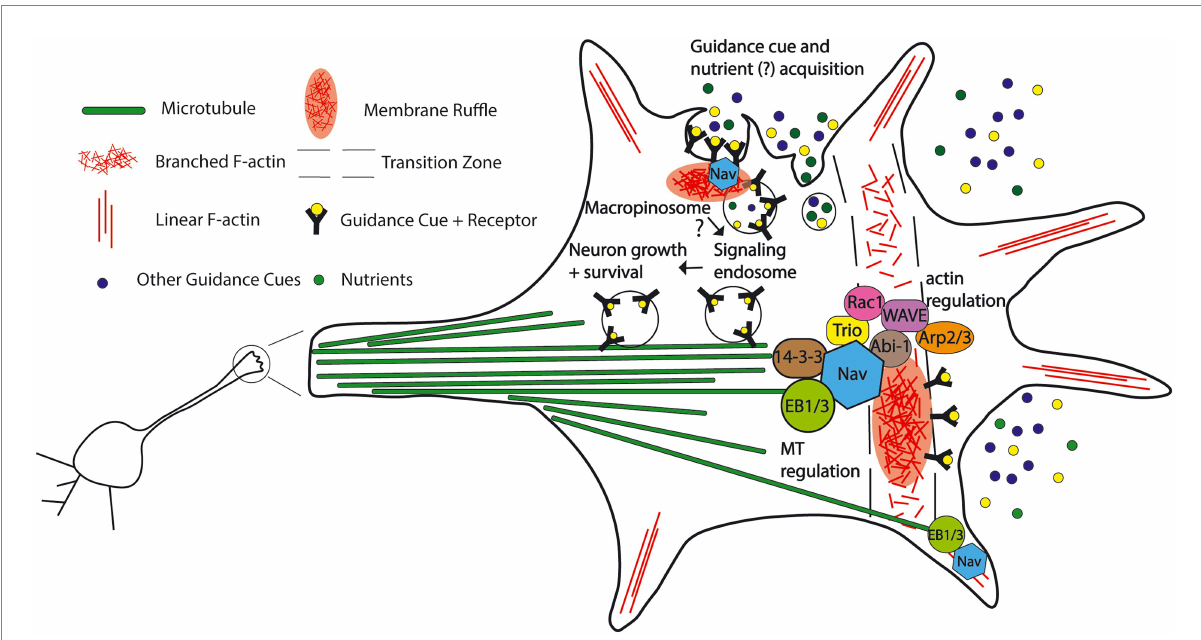
FIGURE 7 Proposed model for the functions and protein interactions of the Neuron Navigators in the neuronal growth cone. A subset of the Navigator population localizes to the plus-tip of microtubules via binding to end binding protein, cross-links microtubules and actin, and influences cytoskeleton dynamics in the growth cone. Nav1 promotes actin-rich membrane ruffles in the transition zone of the growth cone. This may be via binding to other cytoskeleton-associated molecules such as Trio, 14–3-3 family proteins, and members of the WAVE complex. Nav2 and Nav3 may also influence membrane ruffles via their putative actin-binding domain bind to cytoskeleton-associated molecules, and influence neuritogenesis. Nav1 also promotes macropinocytosis, a non-selective fluid-phase endocytosis in the growth cone, including internalization of guidance cues and their receptors, possibly leading to downstream neuron growth regulation via signaling endosomes. Growth cone macropinocytosis may also contribute to extracellular nutrient and metabolite acquisition, as seen in cancer cells. (See text for details and